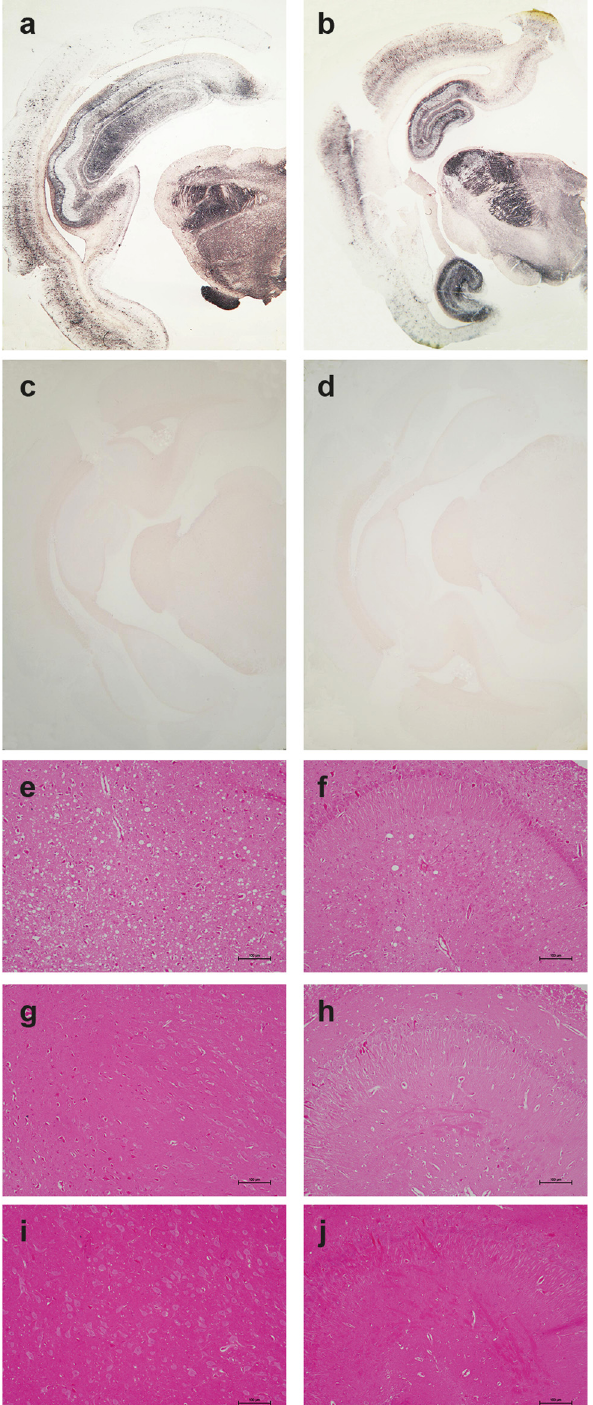
Fig 5. Pathological PrP deposition and vacuolation in the brains of wild-type and tgOv rabbits inoculated with LA21K fast scrapie prions. Midbrain sections from tgOv (a-b, e-f) and wild-type (c, g-i) rabbits challenged with LA21K fast scrapie prions and from a mock-infected tgOv rabbit (d, i-j). (a-d) PET blot analyses using monoclonal antibody Sha31 showed PrP res accumulation solely in LA21K fast challenged tgOv rabbits. (e-j) Hematoxylin and eosin-stained section at the level of the thalamus (e, g, i) and hippocampus (f, h,